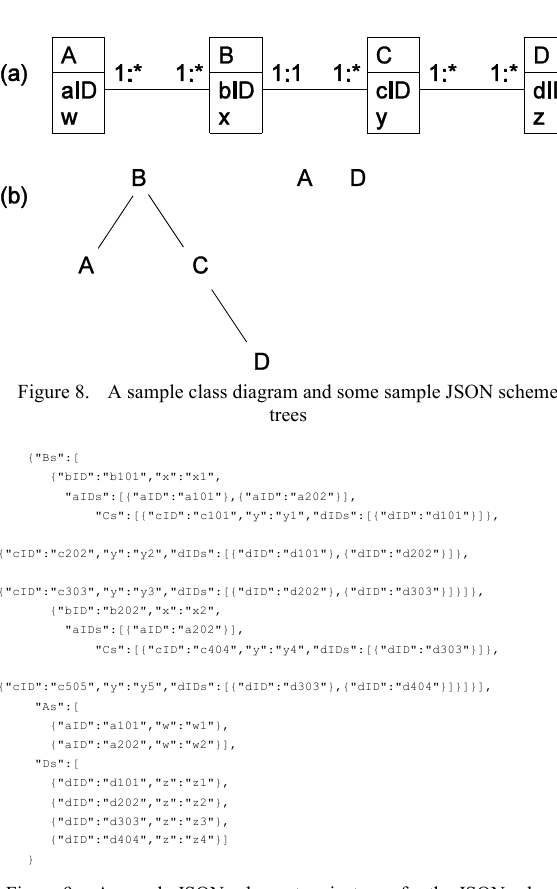
Figure 9. A sample JSON scheme tree instance for the JSON scheme trees in Figure